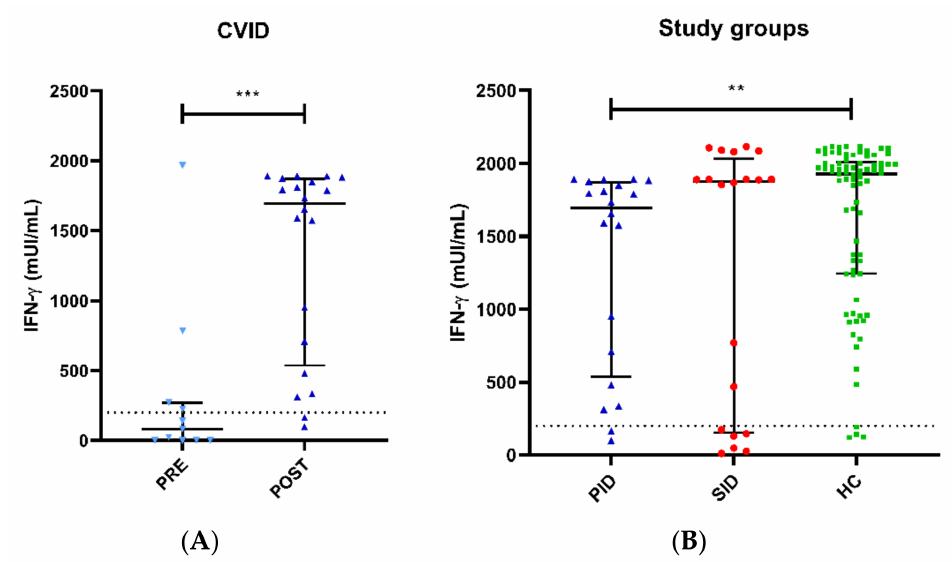
Figure 2. Specific SARS-CoV-2 cellular responses measured by IGRA. ( A ) Pre-vaccine and post- vaccine anti-SARS-CoV-2 IFN- γ levels in PID patients, with titers significantly lower before the vaccine administration with respect to SARS-CoV-2 post-vaccination levels ( p < 0.001). ( B ) Patients with PID are shown in blue and SID in red compared to immunocompetent controls in green. PID patients exhibited significantly lower IFN- γ anti-SARS-CoV-2 titers than HC ( p = 0.005). ** p < 0.01, *** p <